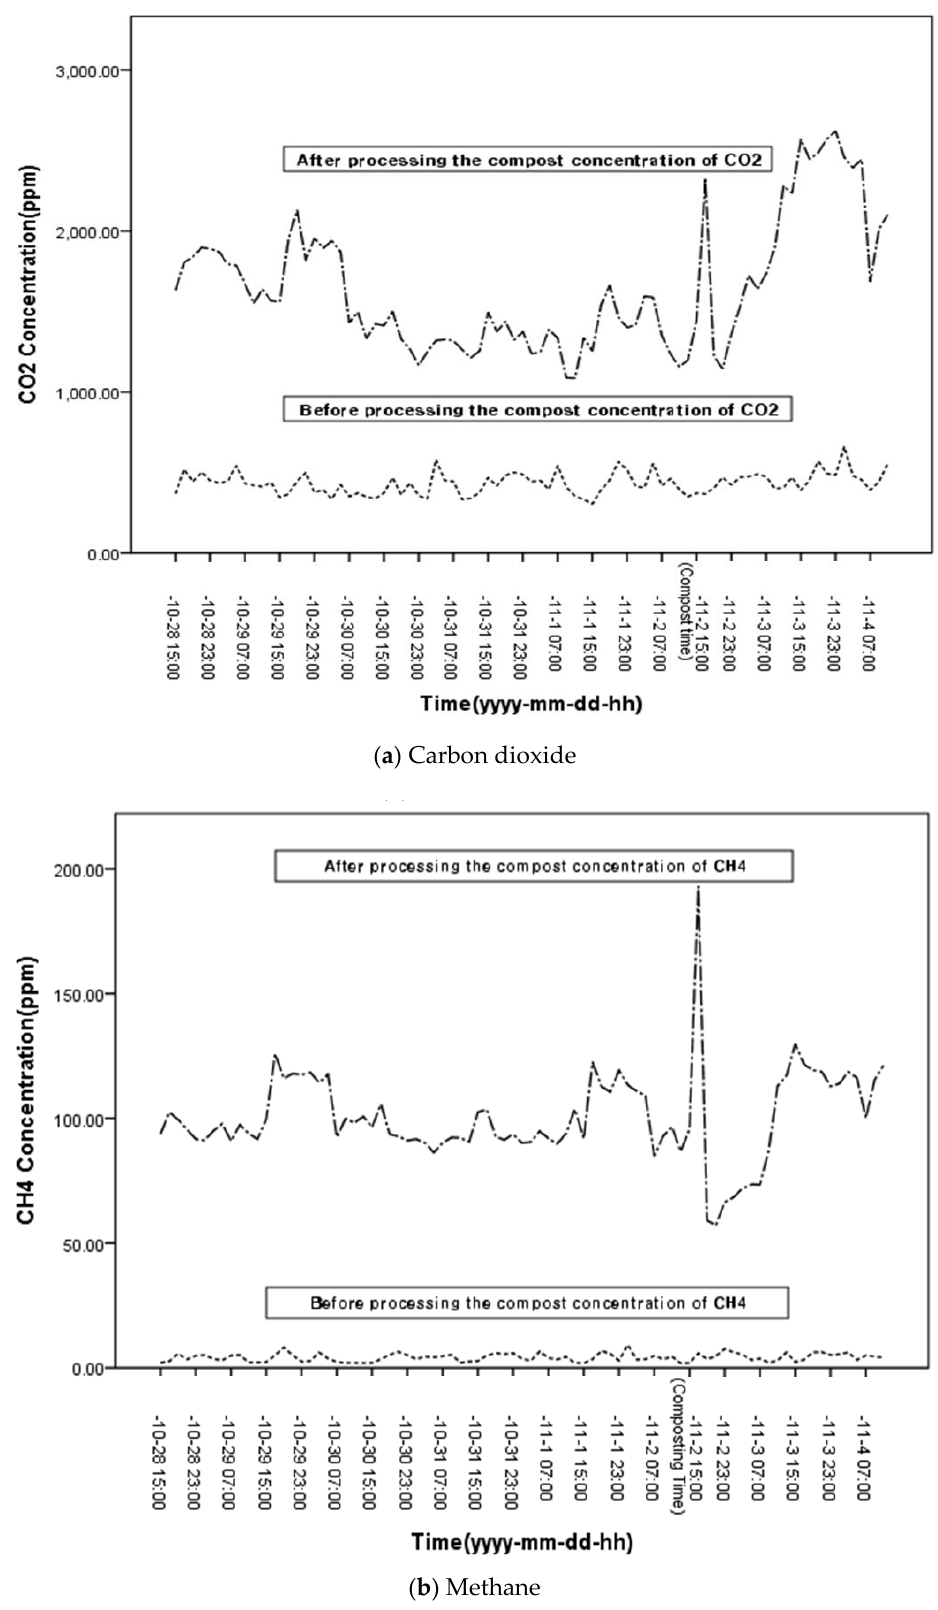
Figure 4. Temporal Distribution of CO 2 and CH 4 Monitored by the Real-time Monitoring System According to the Composting Progress of Swine Manure.